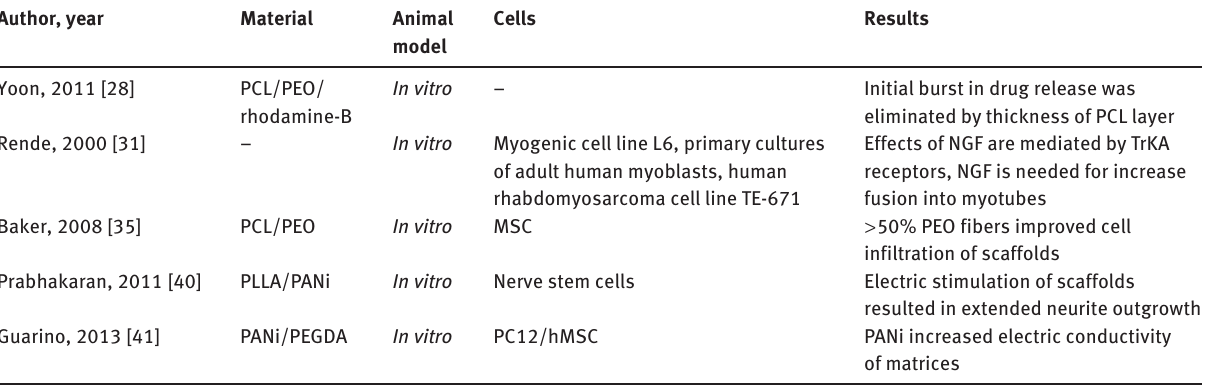
Table 1 Properties of different nanomaterials of muscle tissue engineering. Author,